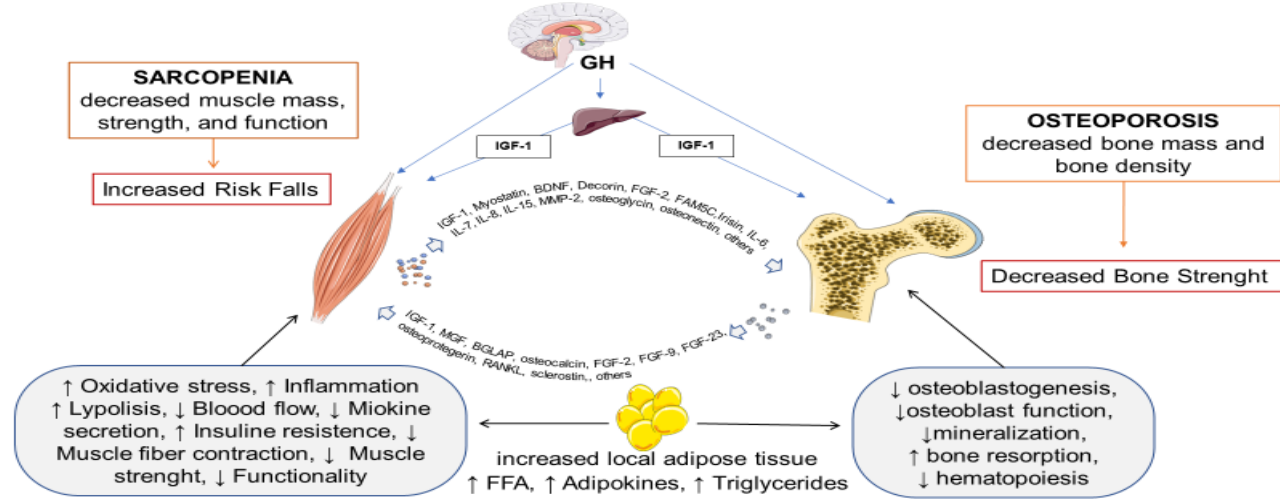
Figure 1. Pathogenesis and etiology of